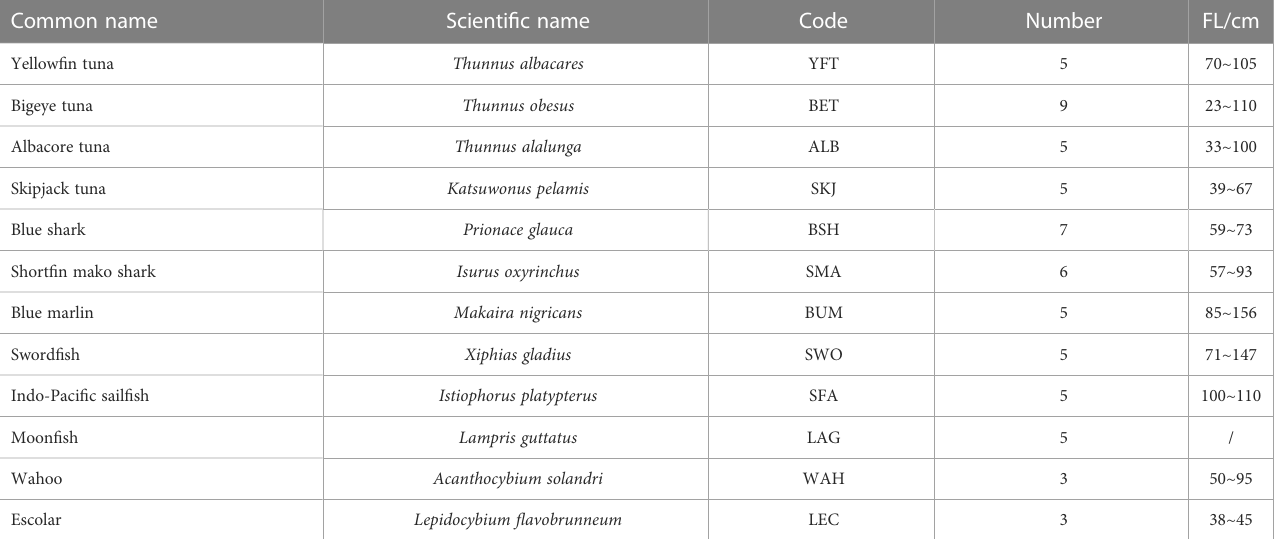
TABLE 1 Biological information of samples in this